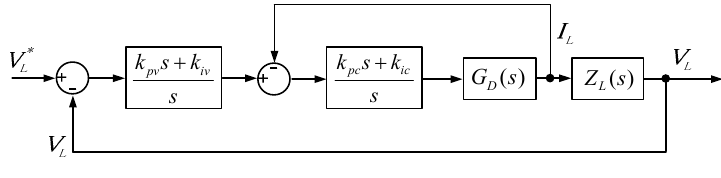
Figure 6. Voltage controller closed ‐ loop block diagram.